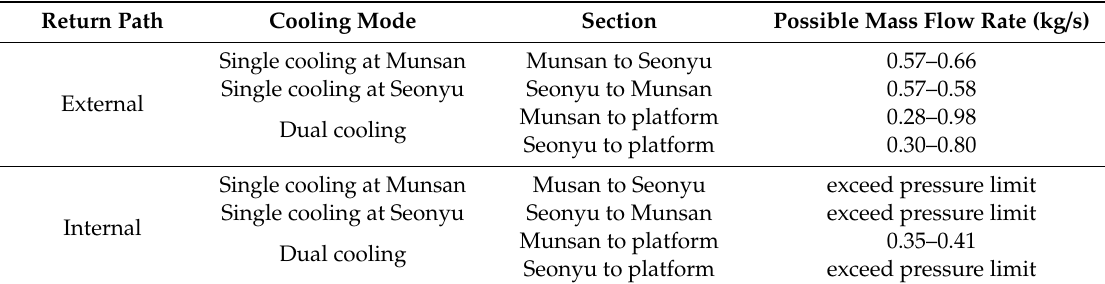
Table 9. Allowable mass flow rates for various cooling